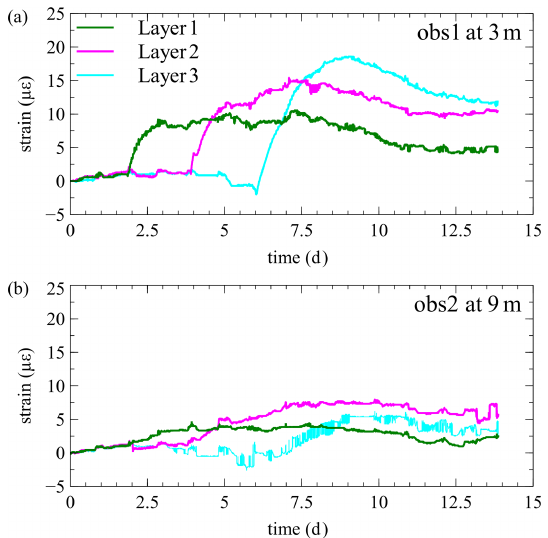
Figure 6. Strain changes with respect to time at depths of approxi- mately 71, 87, and 144m of obs1 (a) and obs2 (b) wells.